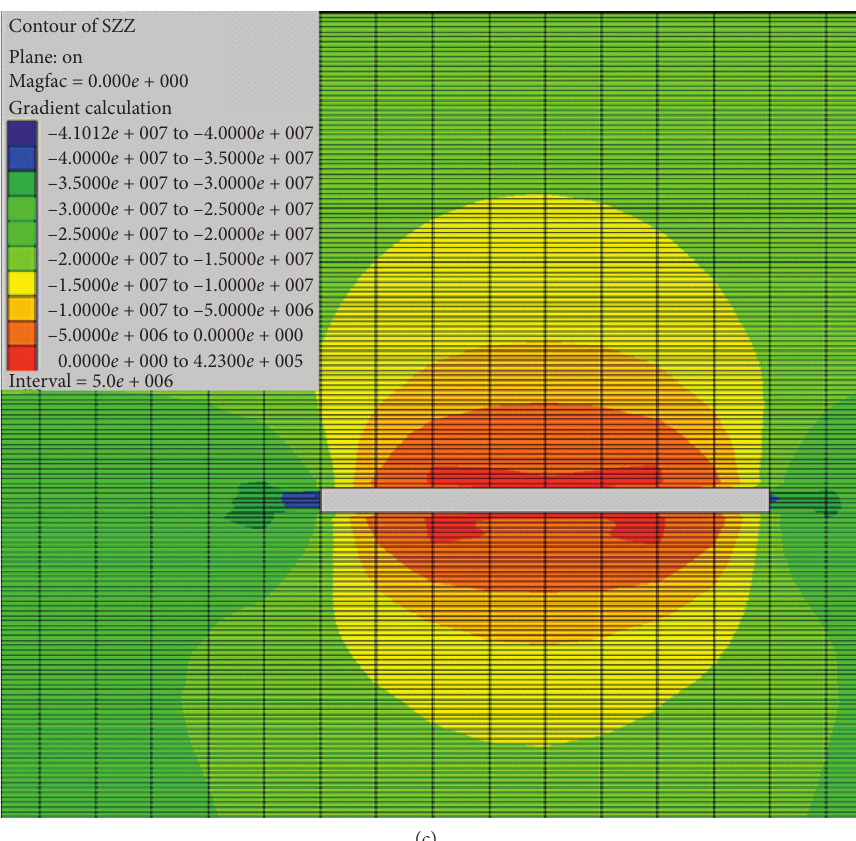
Figure 2: Vertical stress distribution of the floor at different mining distances on the working face. (a) 20m. (b) 80m. (c) 120m.